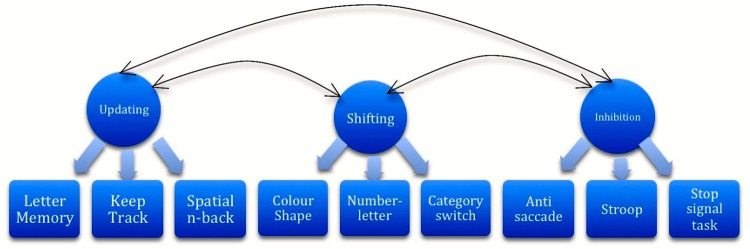
Unified and diverse aspects of executive functioning (Snyder et al., 2015.)